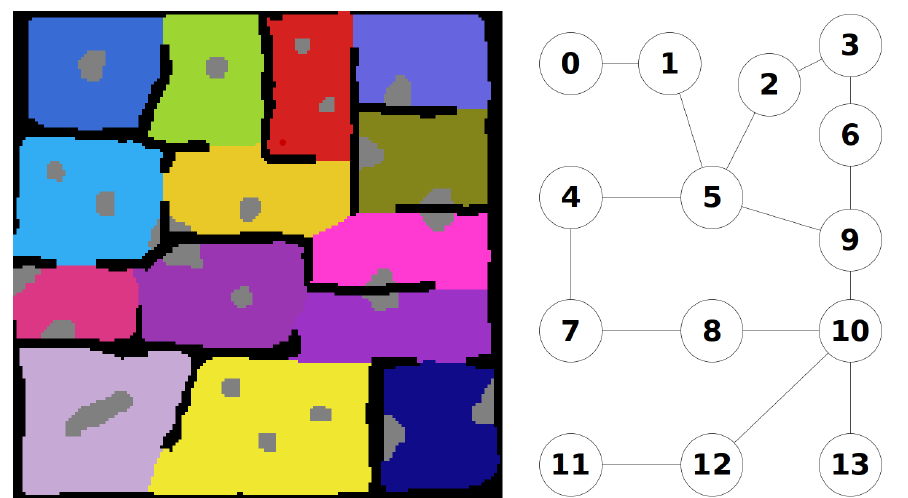
Figure 4. Graph Map Definition From Search Regions. Black Cells : Known Obstacle Cells, White Cells : Explored Empty Cells, Grey Cells : Unknown Obstacle Cells, Coloured Cells : Unexplored Empty Cells (Search Regions).